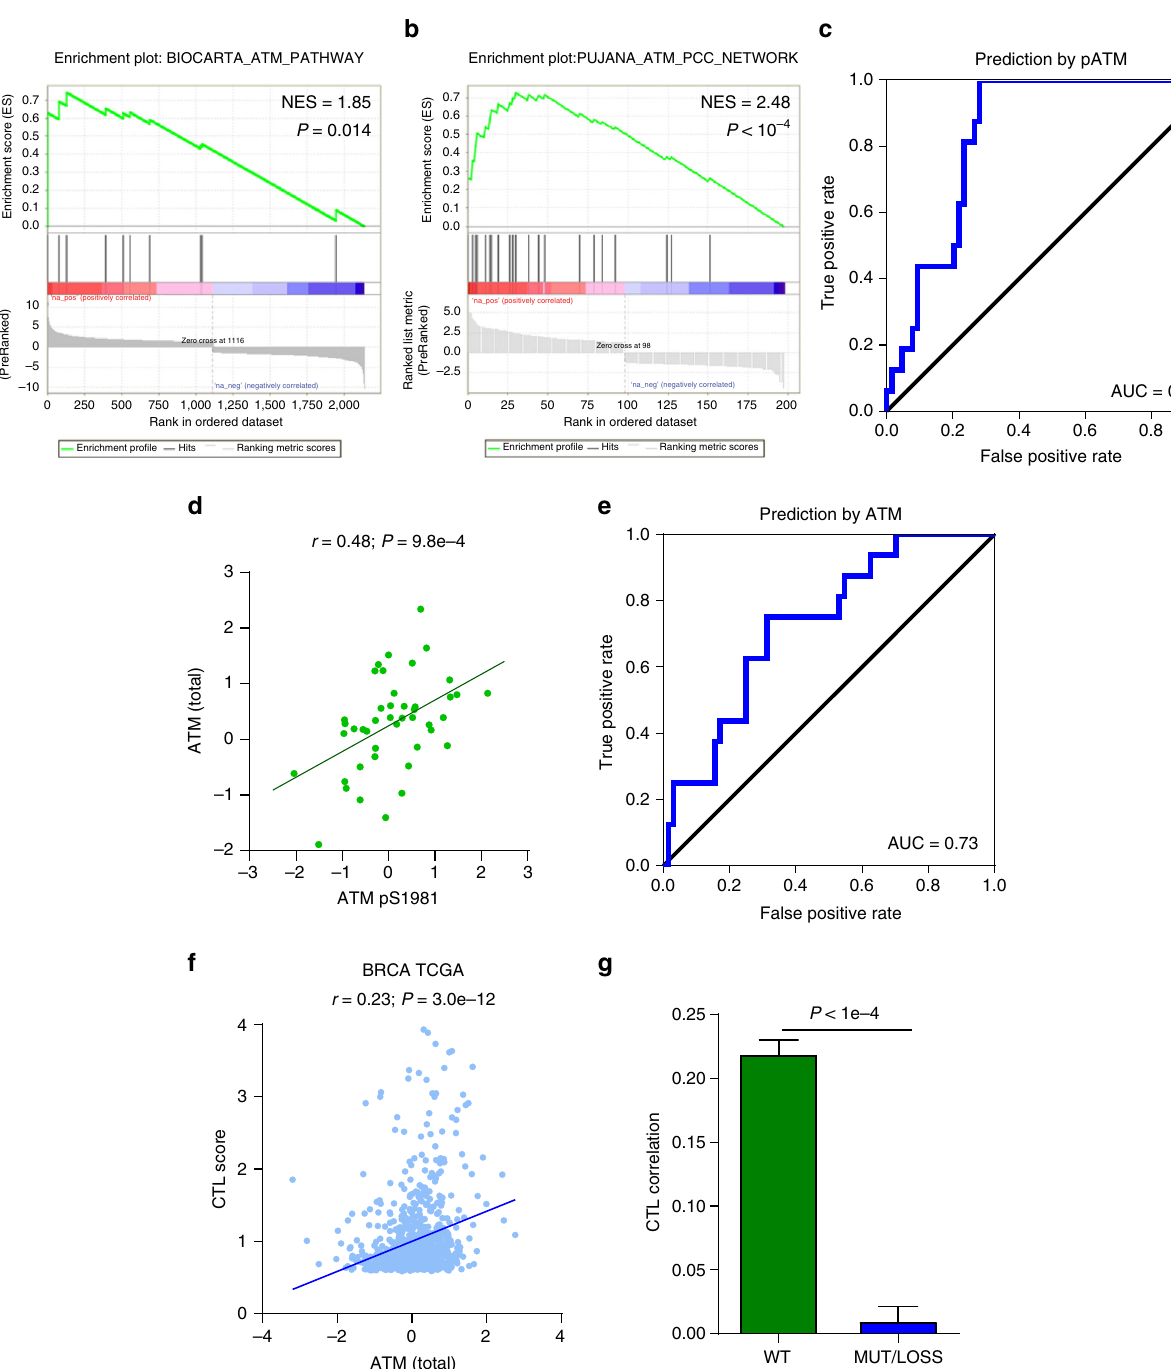
Fig. 4 ATM as a driver of CTL invasion in breast cancer. a Gene set enrichment analysis for differentially expressed phospho-proteins shows enrichment of the ATM pathway. b Gene set enrichment analysis for breast cancer CTL high gene signature (see Supplementary Fig. 5) shows enrichment of ATM related genes. c Receiver-operator characteristic (ROC) plot for prediction of CTL high patients based on ATM phospho-S1981 levels in breast cancer patients. Area under the curve (AUC) equal to 0.82 ( N = 80). d Correlation of total ATM with ATM phosphorylated at serine 1981 ( N = 80). Spearman correlation coef fi cient ( r ) and corresponding P -value indicated above plot. e ROC plot for prediction of CTL high patients by total ATM protein ( N = 80). f Correlation of CTL Score with total ATM determined by RPPA for the TCGA breast cancer cohort ( N = 892). Spearman correlation coef fi cient (r) and corresponding P -value is indicated in the above plot. g Analysis of breast cancer patients with genomic alteration of ATM shows loss of correlation between ATM and CTL invasion compared to patients with wild type (WT) ATM. Correlation coef fi cient distributions were determined by random subsampling of each population to ensure equal sample size. Error bar represents 95% con fi dence interval, P -values determined by